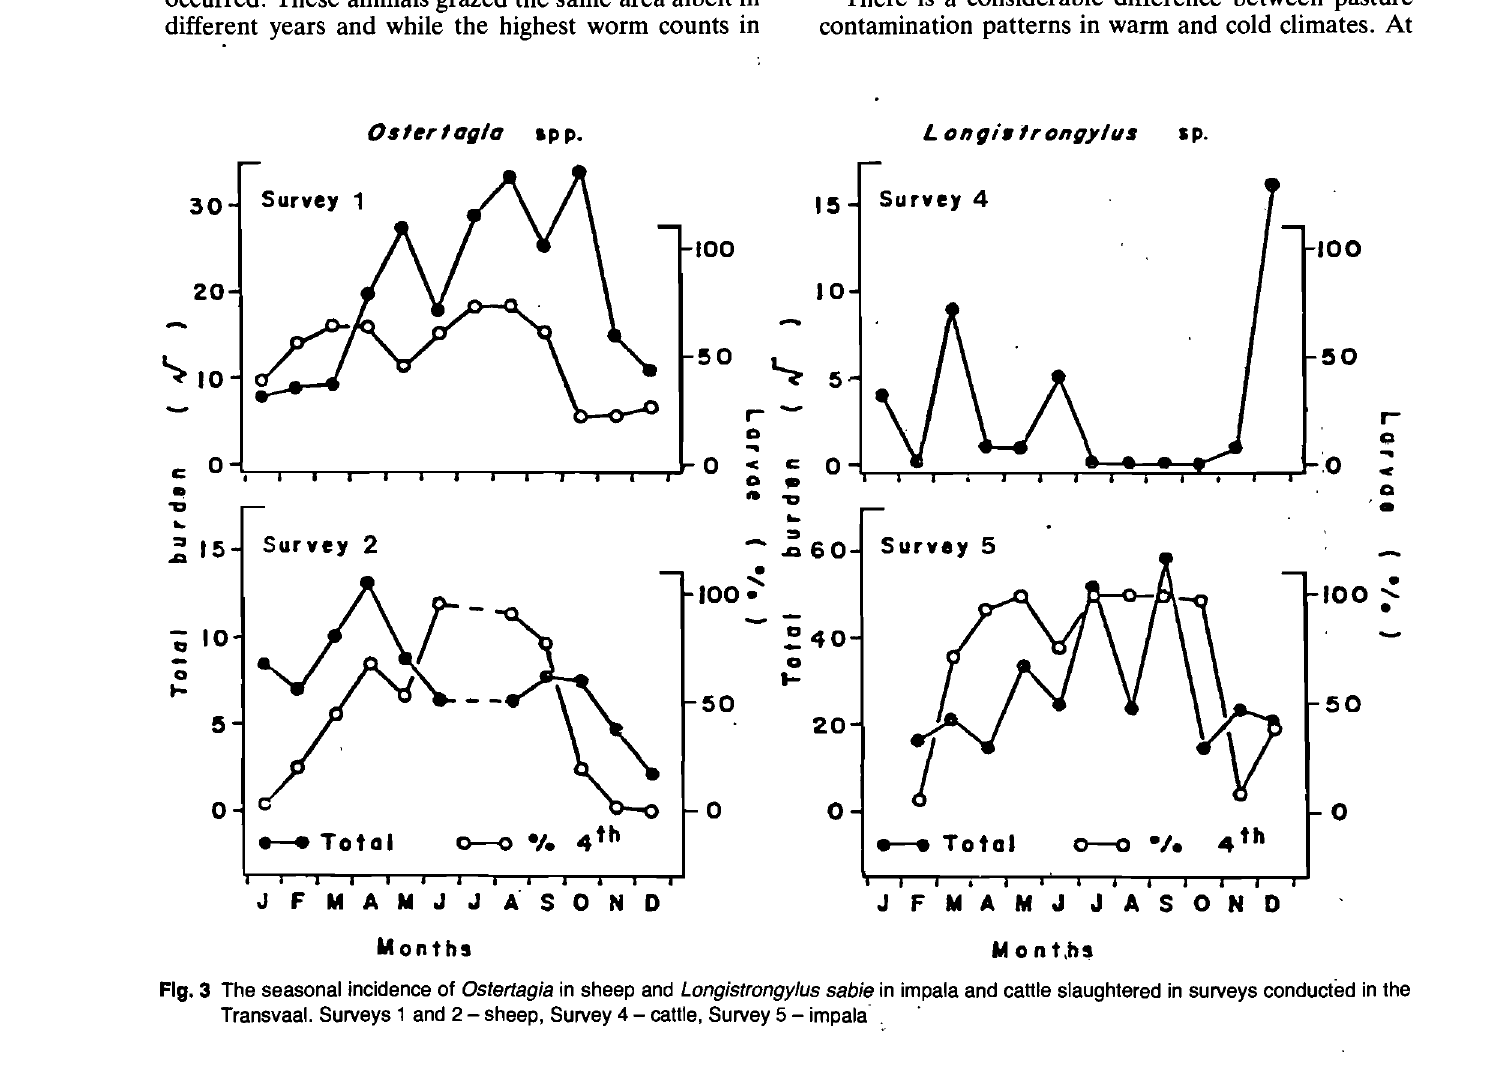
TYDSKRIF V AN DIE SUID-AFRIKAANSE VETERINERE VERENIGING - SEPTEMBER